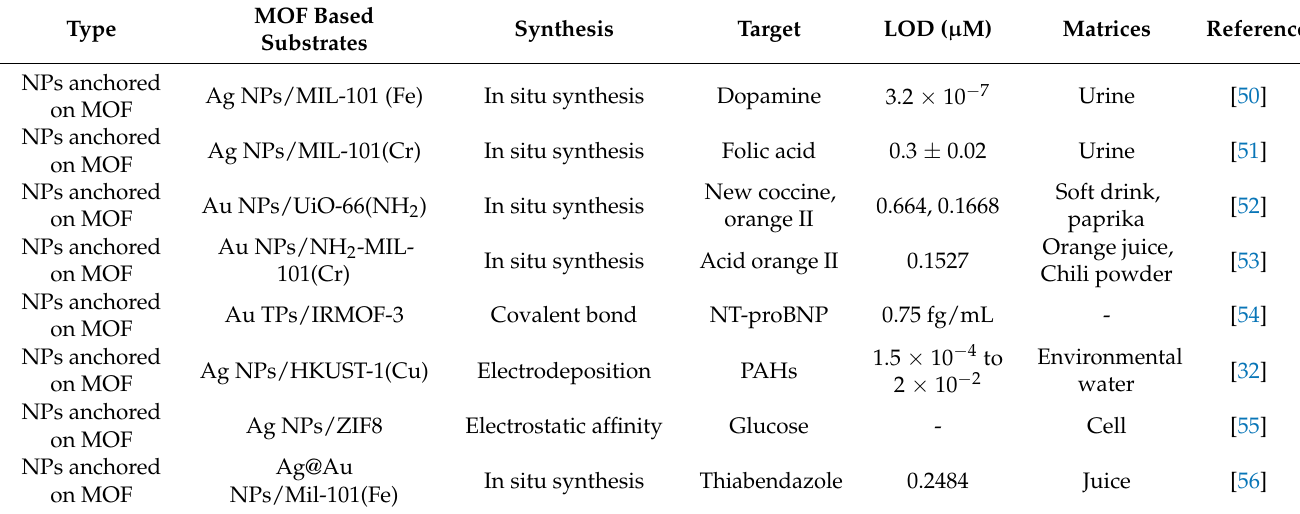
Table 2. Application of composites of SERS-active NPs anchored on the surface of MOFs in